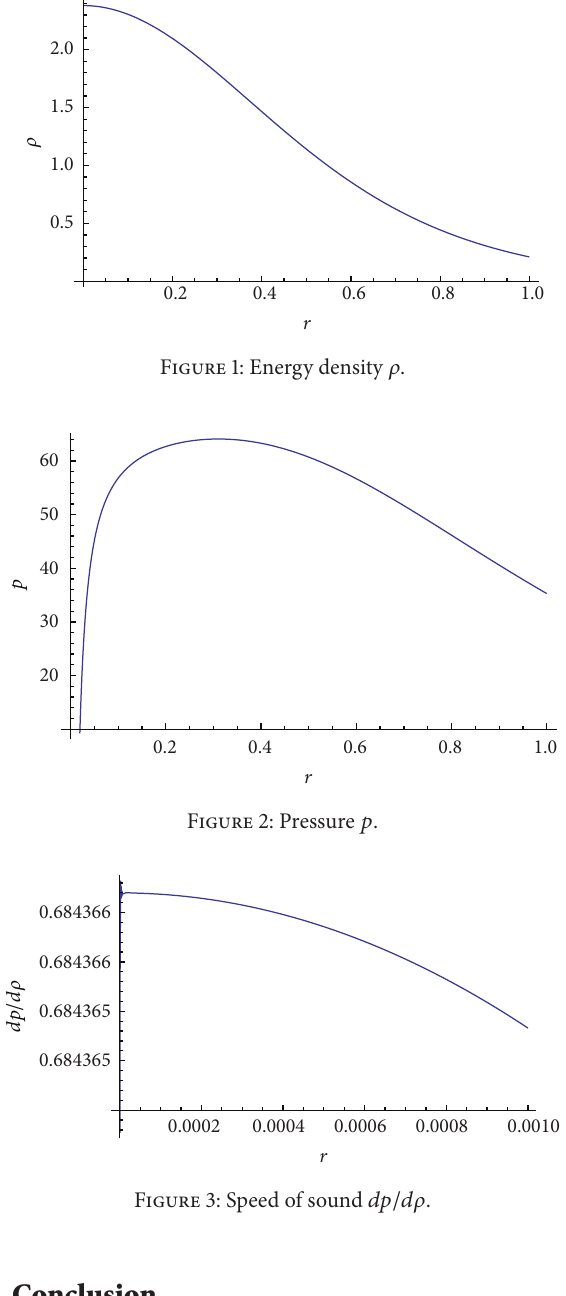
Figure 3: Speed of sound 𝑑𝑝/𝑑𝜌